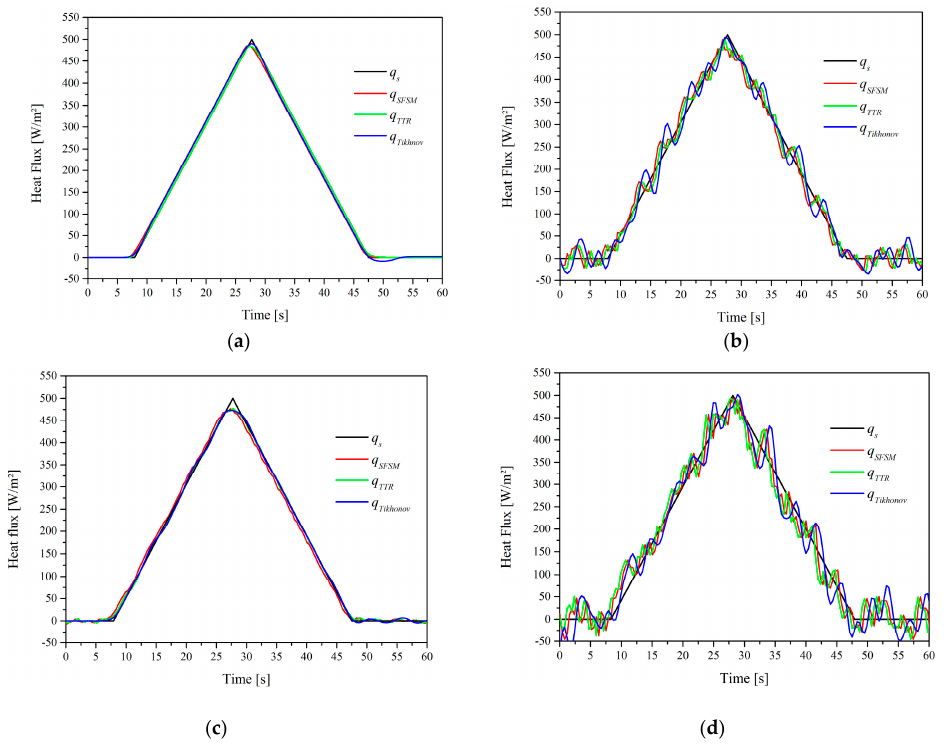
Figure 4. Temperature response for the triangular heat flux.